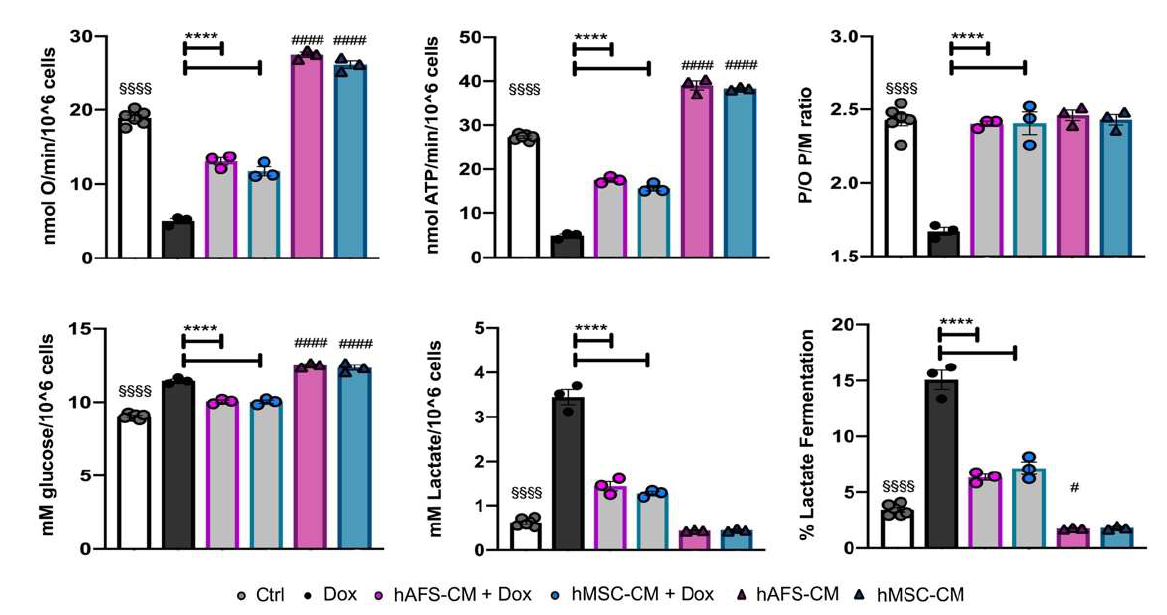
Figure 3. Dox-elicited mitochondrial dysfunction is rescued in mNVCM pretreated with either hAFS-CM or hMSC-CM. From the top left corner: Oxygen consumption rate stimulated with pyruvate plus malate; ATP production by F o -F 1 ATP synthase stimulated with pyruvate plus malate; mNVCM P/O ratio after pyruvate plus malate stimulation, as a marker of OxPhos efficiency; Glucose consumption; lactate release; lactate fermentation percentage. All the biochemical measurements were performed in mNVCM treated as follows: control condition ( Ctrl ), after exposure to 1 µ M Dox ( Dox ), pretreated with hAFS-CM or hMSC-CM before the Dox stimulation ( hAFS-CM+Dox and hMSC-CM + Dox , respectively), or only pretreated with hAFS-CM or hMSC-CM (HAFS-CM and hMSC-CM, respectively). In each panel, values are expressed as the mean ± SEM of the independent experiments; hAFS-CM vs. Ctrl and hMSC-CM vs. Ctrl # p = 0.0495 or #### p < 0.0001; Ctrl vs. Dox §§§§ p < 0.0001; hAFS-CM + Dox vs. Dox and hMSC-CM + Dox vs. Dox **** p < 0.0001.